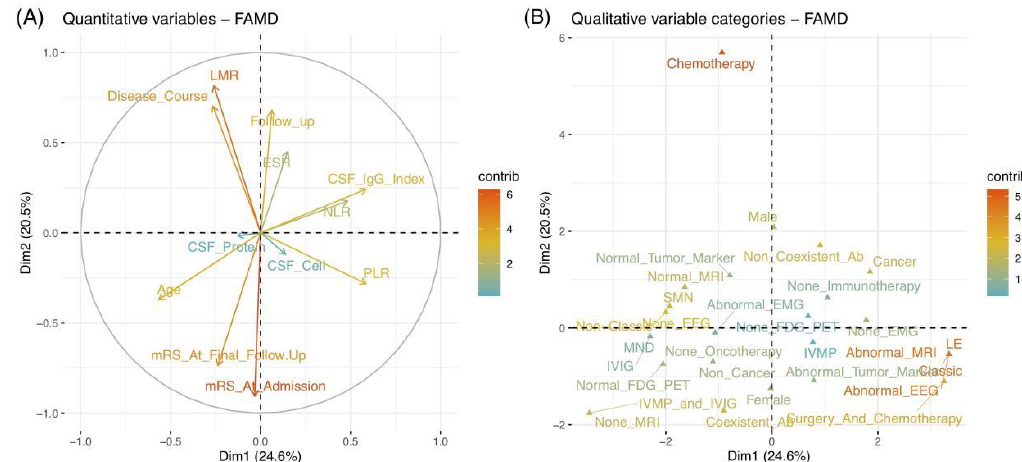
Figure 2. Correlation plots of quantitative ( A ) and qualitative ( B ) variables. The X-axis and Y-axis represent Dim 1 (24.6%) and Dim 2 (20.5%) with respective cumulative variance percent in brackets. The variables were highlighted by their contribution values with arrows ( A ) and points ( B ). A higher value with a redder color indicates better contributions in Dims. ( A ) The correlation circle indicates that the closer the arrow to the axis represented greater contribution of the variable on that axis (Dim). The angle of the 2 variables suggests their positive or negative correlation. ( B ) The scatter plot reveals the contributions of each variable in the different poles of Dims. A good representation of a variable was reflected by the farther distance between the point of the variable and the origin on the factor map. Abbreviations: ab, antibody; CSF, cerebrospinal fluid; Dim, dimension; EEG, electroencephalograms; EMG, electromyography; ESR, erythrocyte sedimentation rate; FAMD, factor analysis of mixed data; FDG-PET, 18 F-fluorodeoxyglucose positron emission tomography; IVMP, intravenous methylprednisolone; IVIG, intravenous immunoglobulin; LE, Limbic encephalitis; LMR, lymphocyte to monocyte ratio; MND, motor neuron diseases; MRI, magnetic resonance imaging; mRS, modified Rankin Scale; NLR, neutrophil-to-lymphocyte ratio; PLR, platelet-to-lymphocyte ratio; SMN, sensorimotor neuropathies.